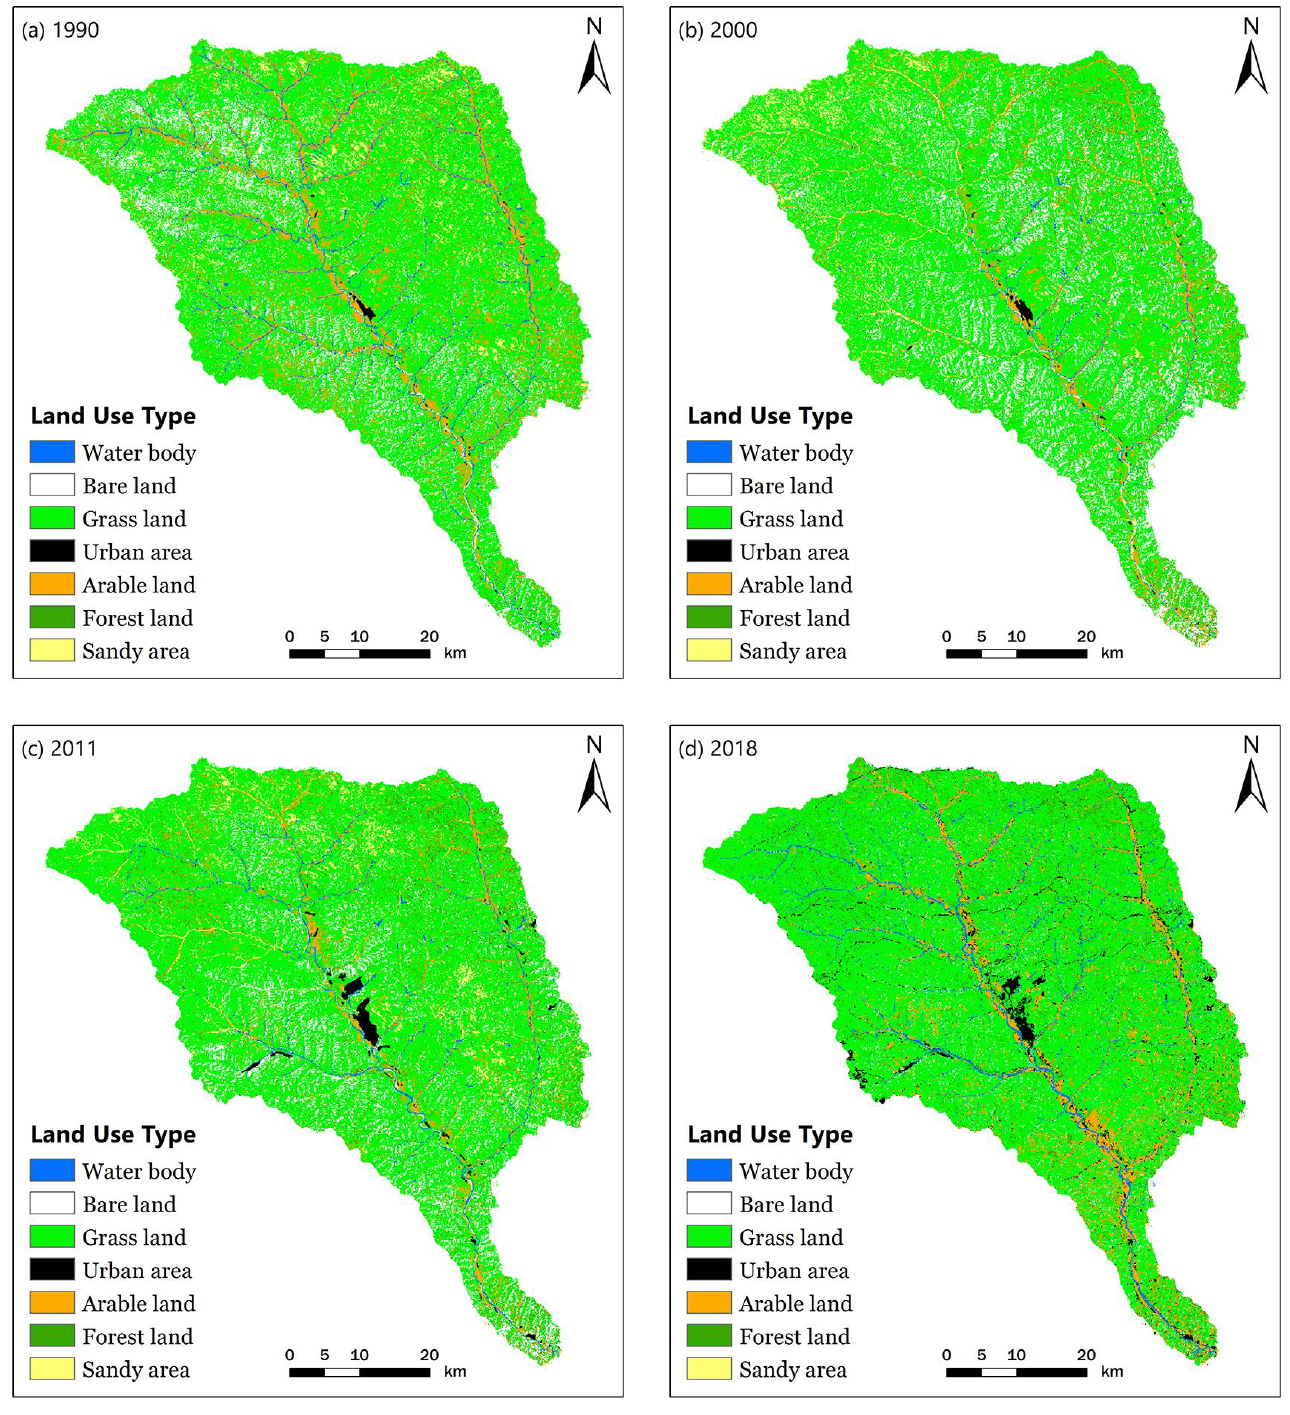
Figure 7. Land use changes in the Huangfuchuan watershed. ( a ) Land use map in 1990. ( b ) Land use map in 2000. ( c ) Land use map in 2011. ( d ) Land use map in 2018.